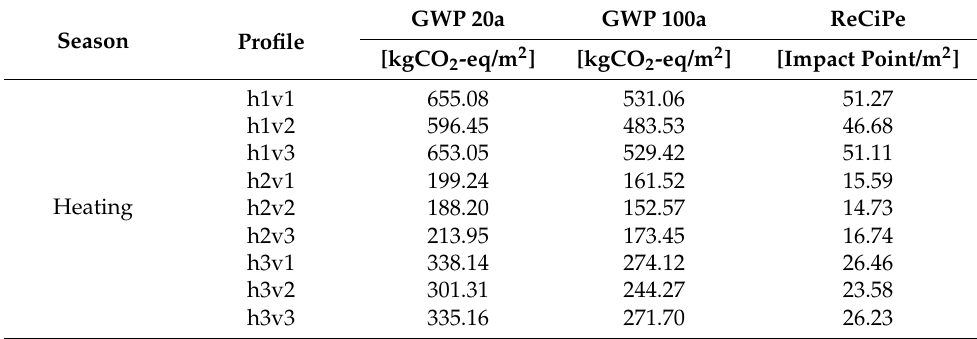
Table 11. Impact assessment during the operational stage for 90-year lifetime (LCA cc